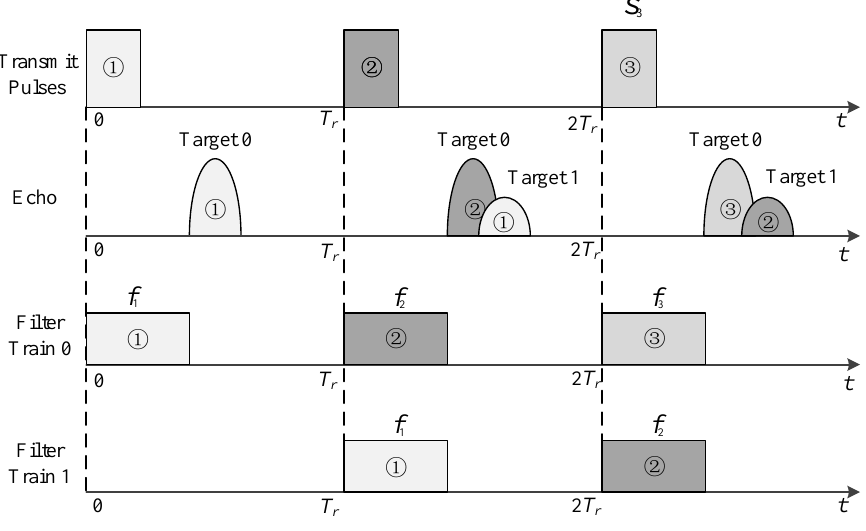
Figure 1. Echo and reference pulse diagram for a diverse pulse train.